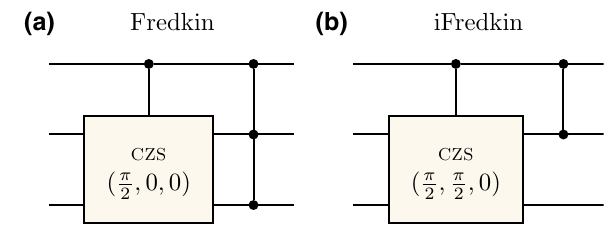
FIG. 3. Converting CCZS gates into other three-qubit gates. (a) Constructing a Fredkin gate with a CCZS (π/ 2, 0, 0 ) gate and a CCZ gate. (b) Constructing an iFredkin gate from a CCZS (π/ 2, π/ 2, 0 ) gate and a CZ gate.